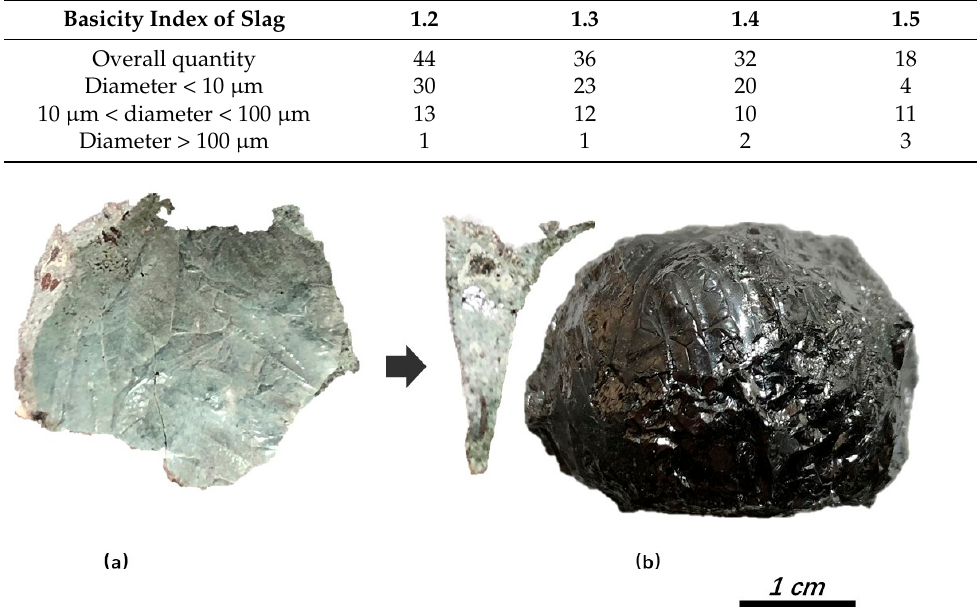
Figure 3. Solidified surface of slag that contacted with silicon ( a ) and cross-section of solidified slag and the contacted silicon lump ( b ).